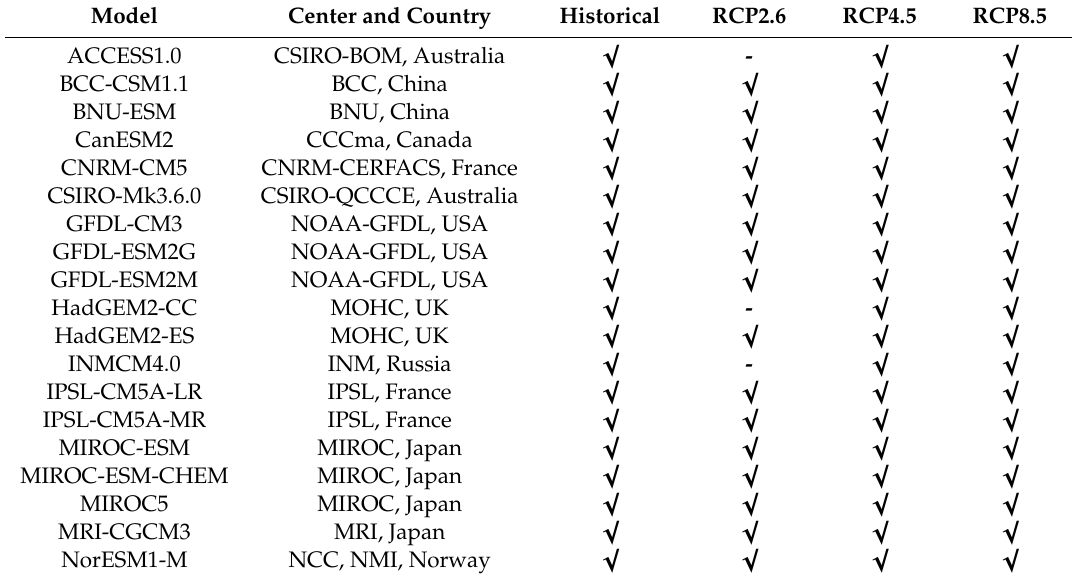
Table 1. Overview of the GCMs used in this